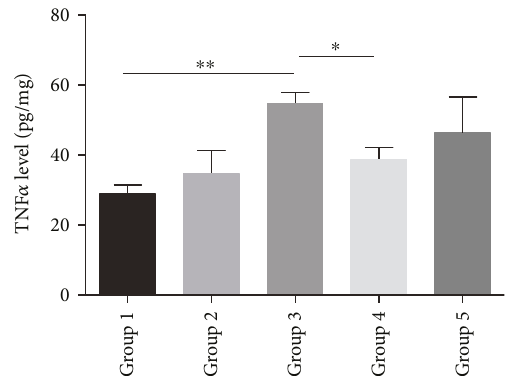
Figure 3: Administration of Bi fi co and concentration of TNF α . The colonic levels of TNF α were increased in the colitis group (3) compared to the normal group (1) ( P < 0 01 ) and decreased in the Pretreated- Bi fi co -colitis group (4) and pretreated +treated- Bi fi co - colitis group (5) ( P 1 < 0 05 and P 2 = 1 00 , resp.). Data are means ± SEM ( n = 8 – 11/group). ∗ P < 0 05 and ∗∗ P < 0 01